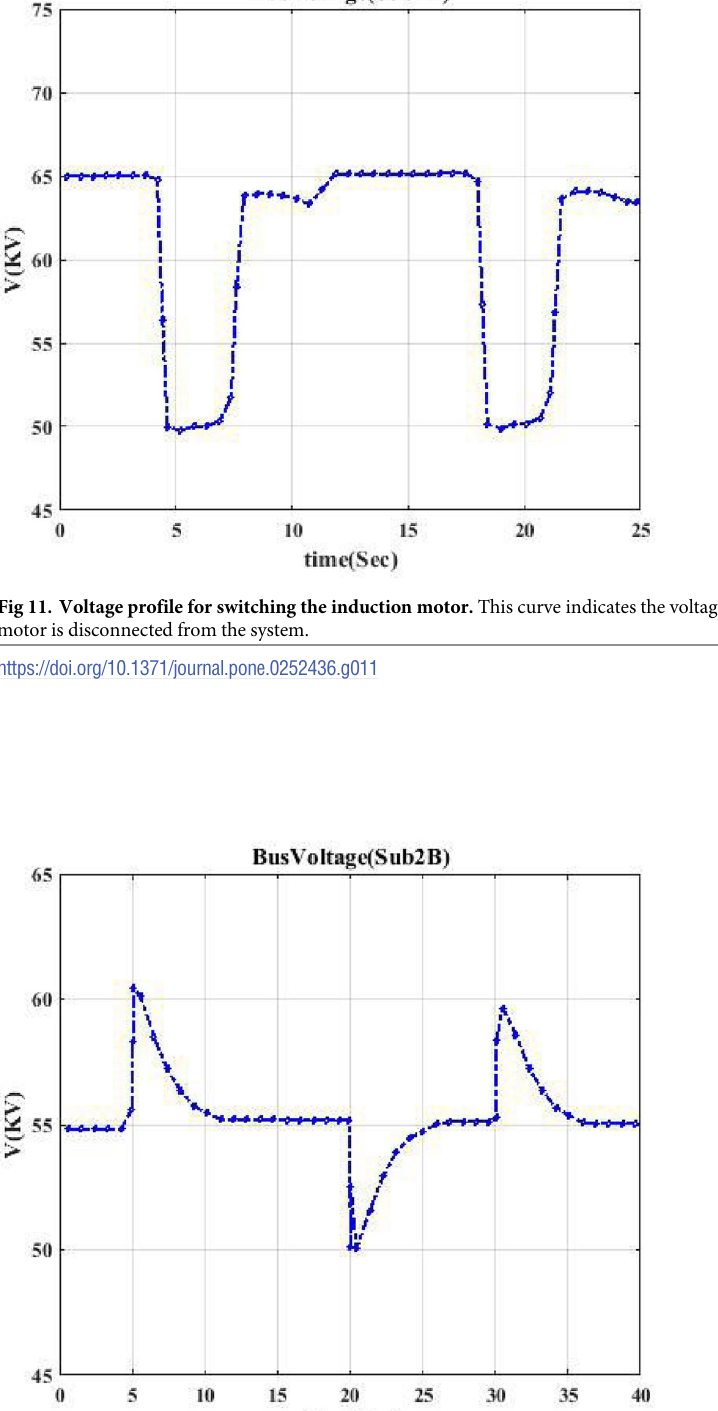
PLOS ONE | https://doi.org/10.1371/journal.pone.0252436 June 1, 2021 16 /